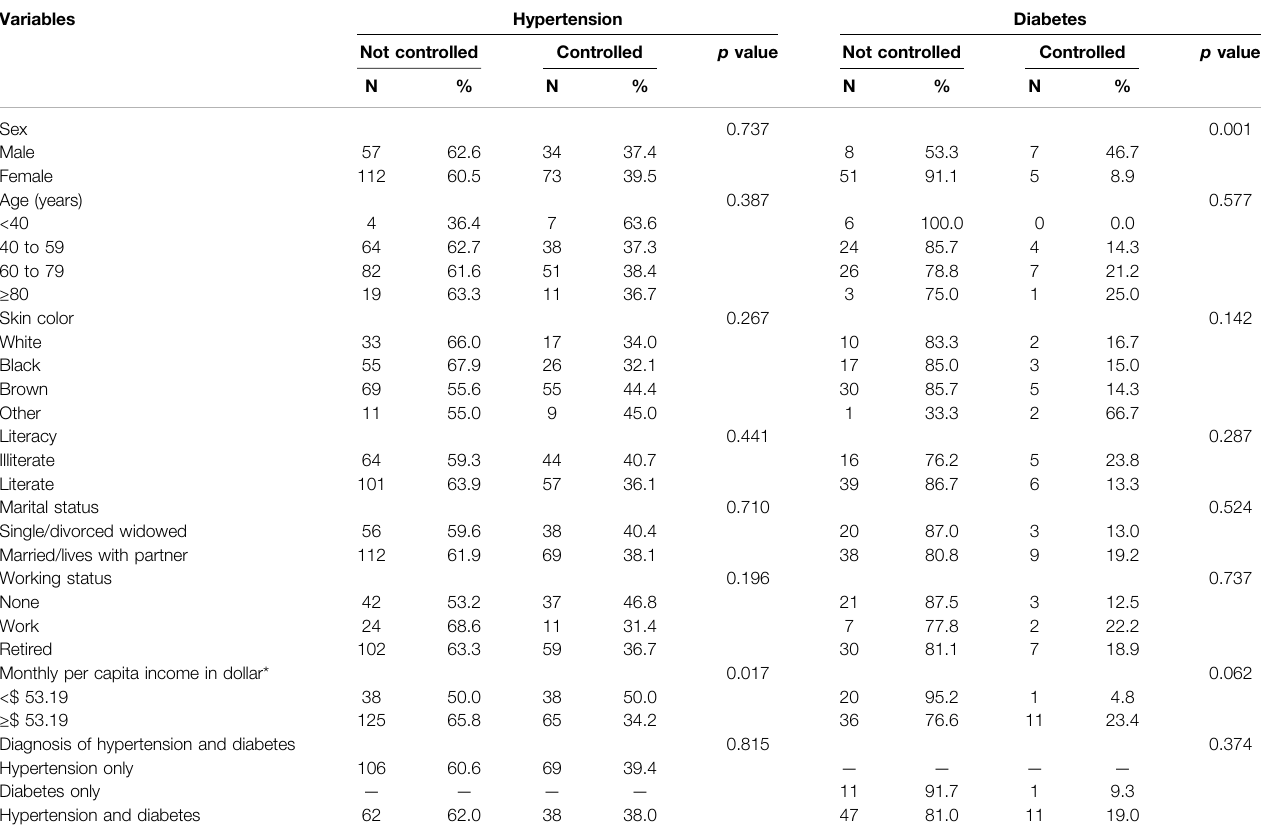
TABLE 3 | Assessment of hypertension and diabetes control by sociodemographic characteristics.